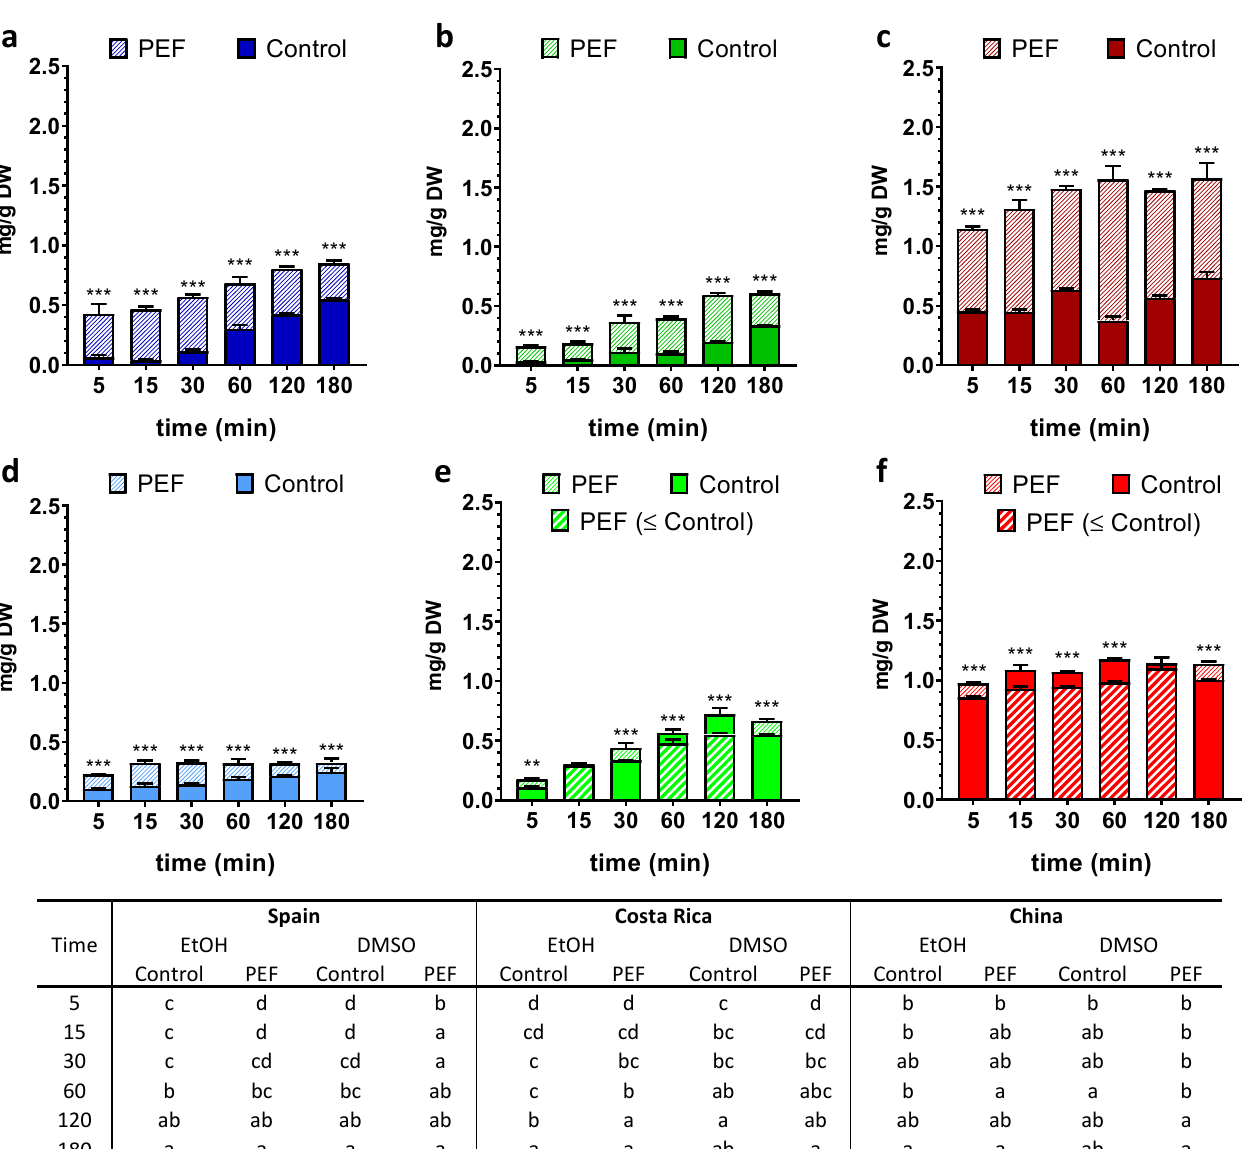
Figure 4. Chlorophyll b content of Spirulina extracts with PEF treatment or without PEF treatment (Control) for ethanol:water ( a – c ) and DMSO:water ( d – f ) solvent from Spirulina cultivated in different geographical regions (blue: Spain, green: Costa Rica, red: China). Statistical differences related to the PEF treatment are represented by asterisks (*). Statistical differences related to the extraction time are represented by different lower-case letters in the table. ** = p < 0.01; *** = p < 0.001. Similarly, the highest C b contents (1.57 ± 0.09 and 1.14 ± 0.02 mg/g DM) were obtained for PEF-treated Spirulina from China in the extract of EtOH and DMSO, respectively. However, in this case, PEF pre-treatment did not produce an interesting improvement in C b extraction (Figure